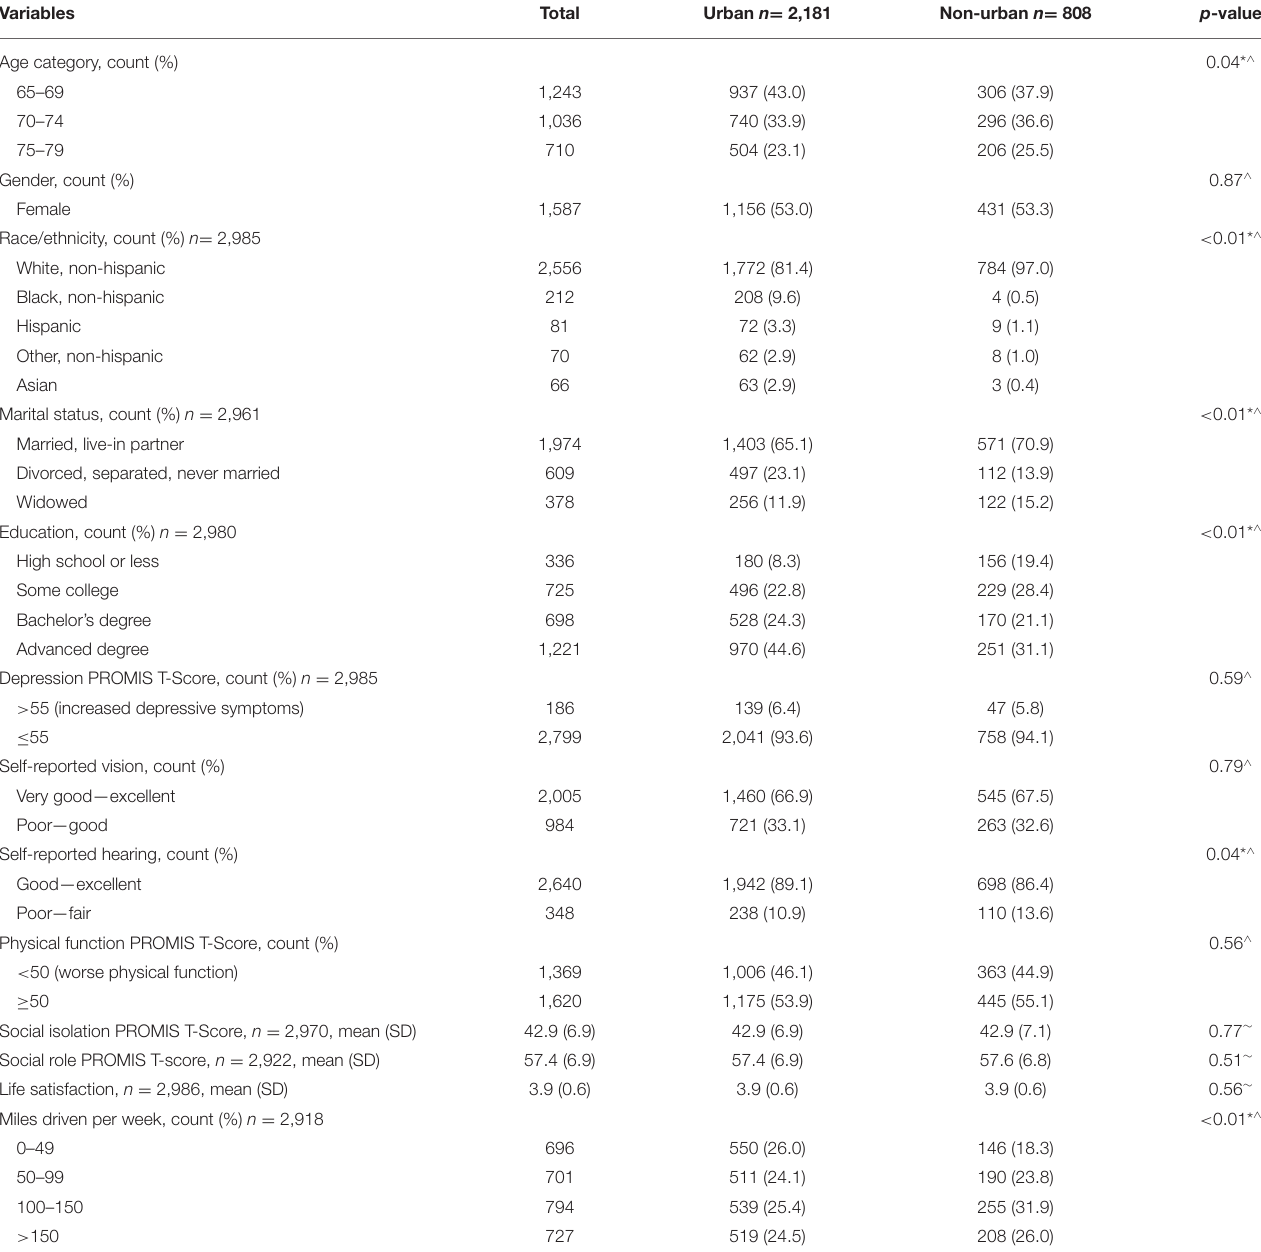
TABLE 1 | Baseline characteristics by geographic status =